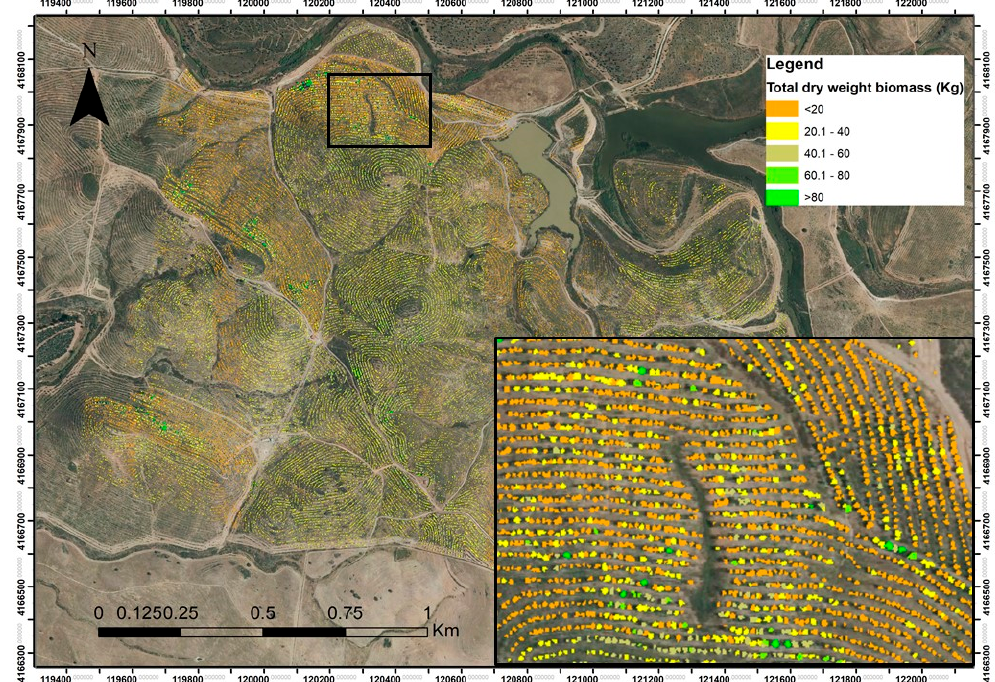
Figure 2. Cartography of biomass C stocks in the Quercus ilex ‐ Q. suber plantation at Puebla de Guzmán (Huelva, Southwestern Spain).